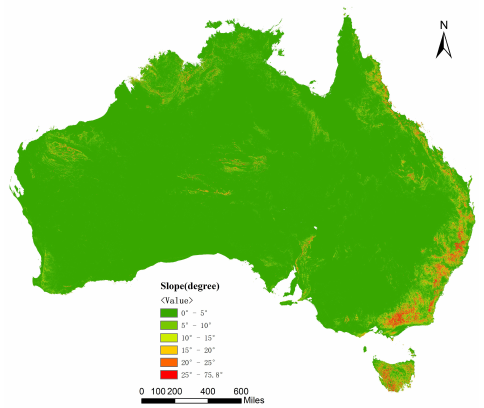
Figure 15. The slope map of the Spark-based algorithm.